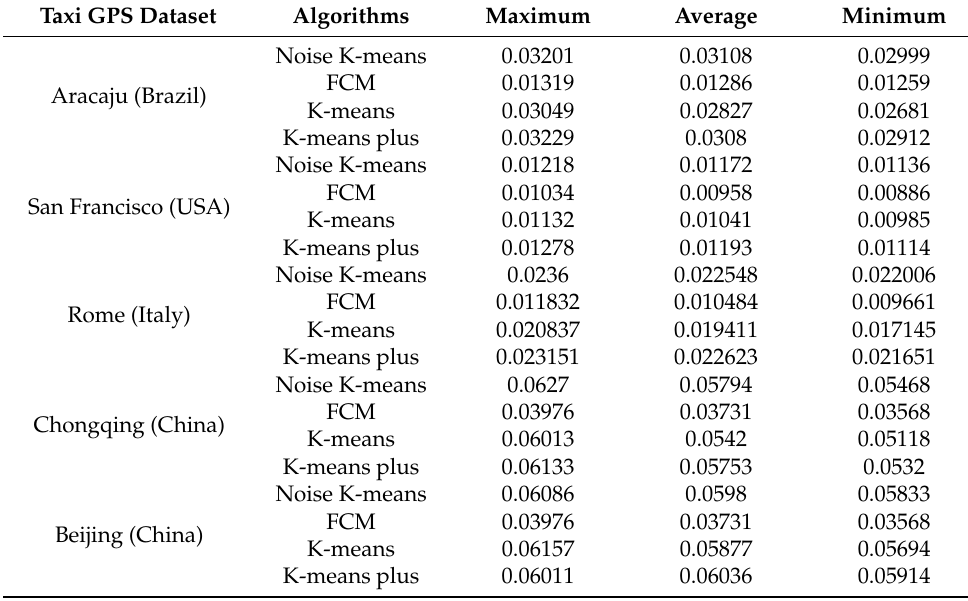
Table 4. Comparison results of PBM index evaluation values.